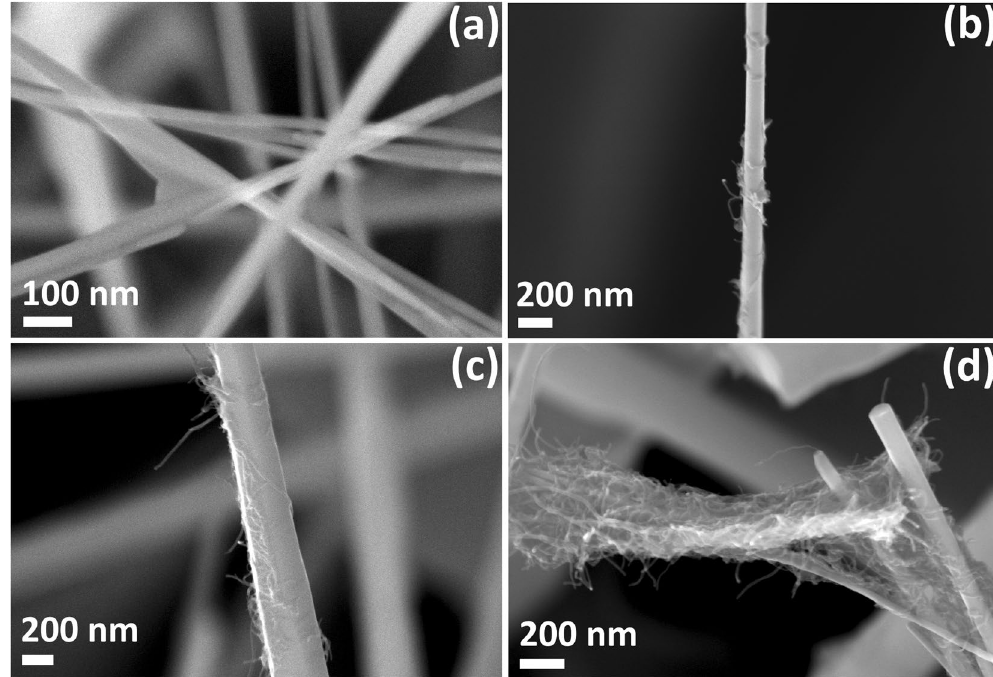
Figure 1. Morphological evolutions of pure and CNT hybridzed ZnO nanowire networks: SEM images of ZnO-CNT NWs with: ( a ) 0.0 wt% CNT; ( b ) 0.4 wt% CNT; ( c ) 2.0 wt% CNT; and ( d ) 4.0 wt%